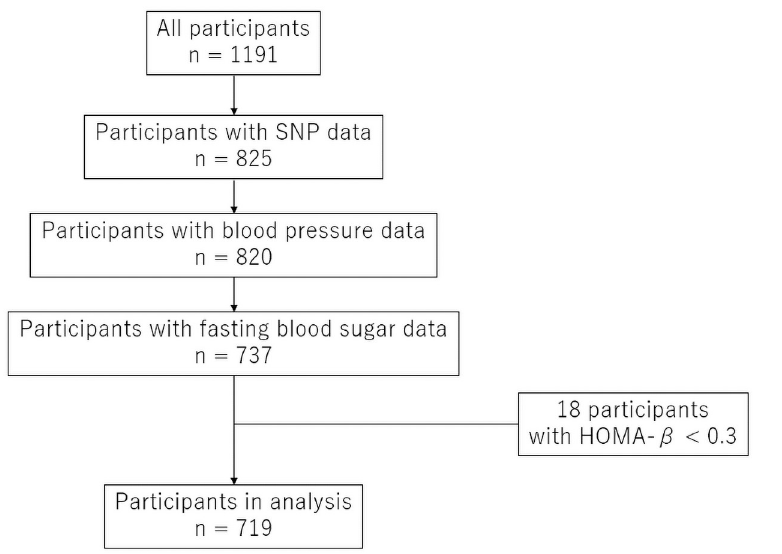
Fig 1. Participant recruitment